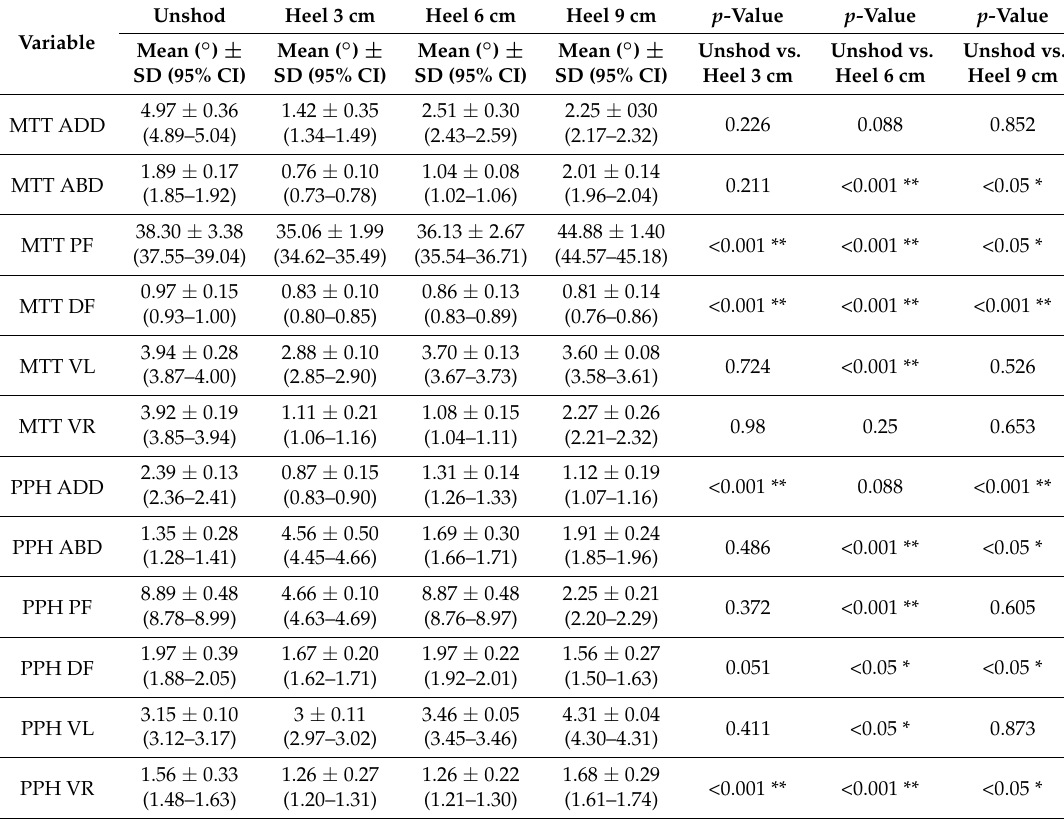
Table 5. DYNAMIC mobility grades of first metatarsal (sensor 1) and proximal phalanx of hallux (sensor 2) bones in unshod as well as heels 3 cm, 6 cm and 9 cm high.